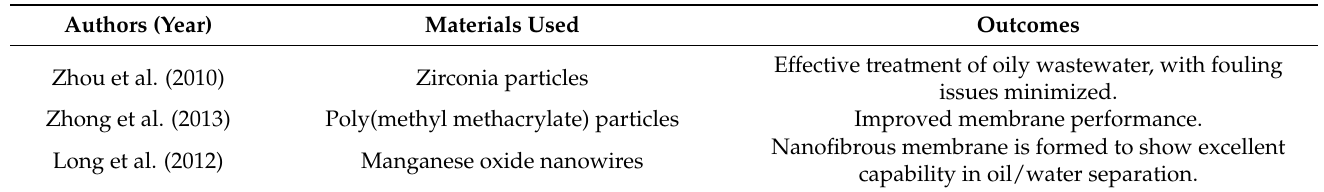
Table 12. Recent studies on functional material-modified membranes for wastewater